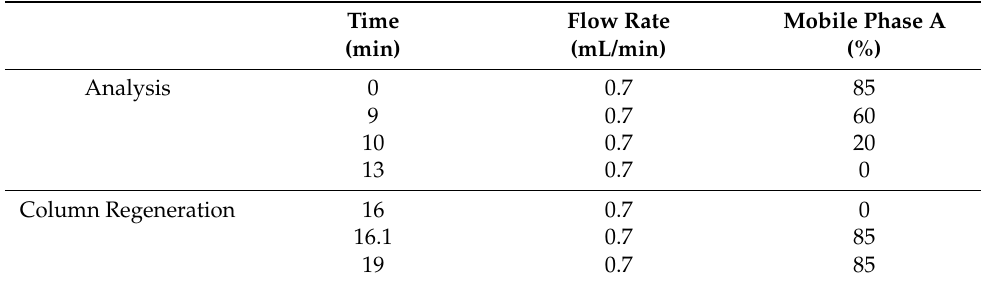
Table 5. LC-gradient conditions for center